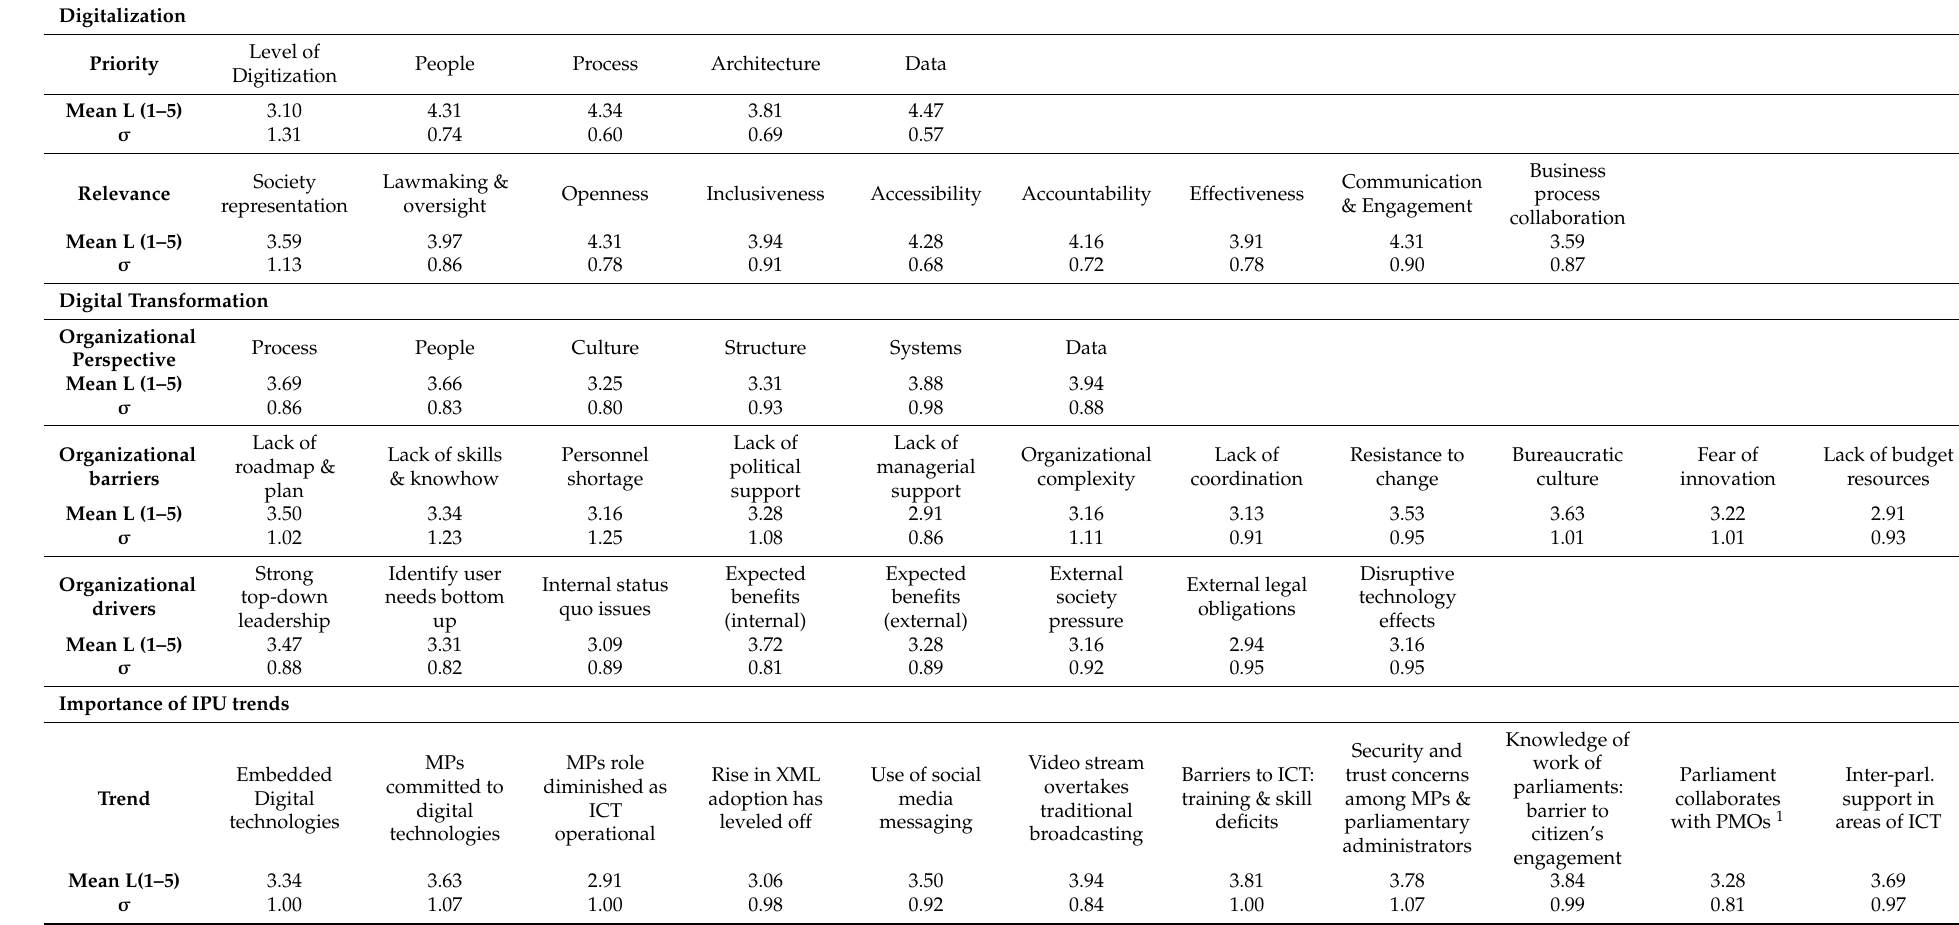
Table A2. Expert study aggregated